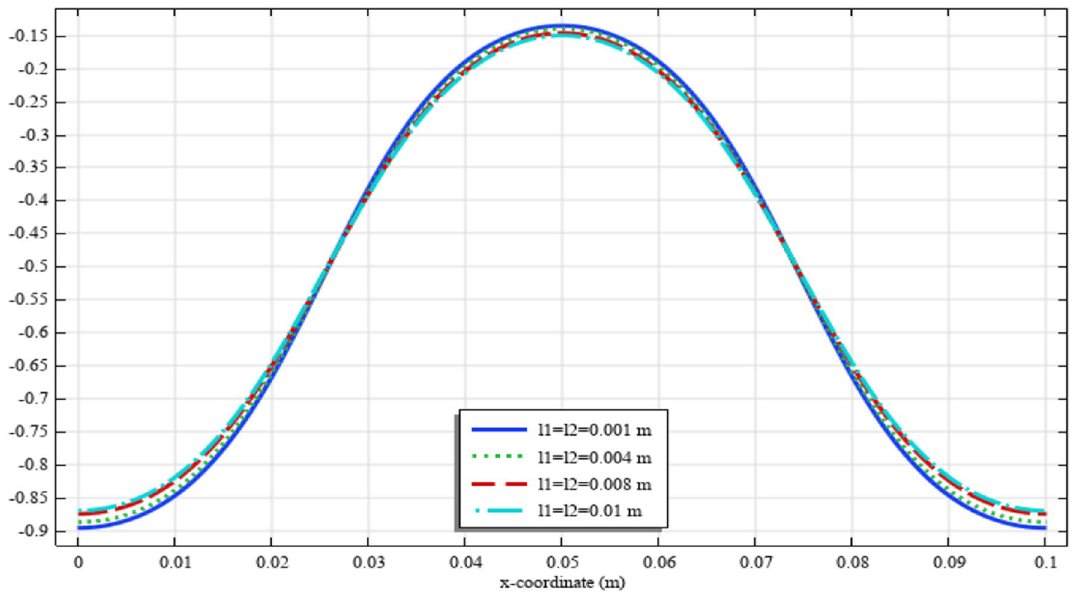
Figure 19. The displacement u y ( x , b / 2 )/ | u 0 | for different values of ℓ 1 and ℓ 2 (COMSOL Multiphysics).